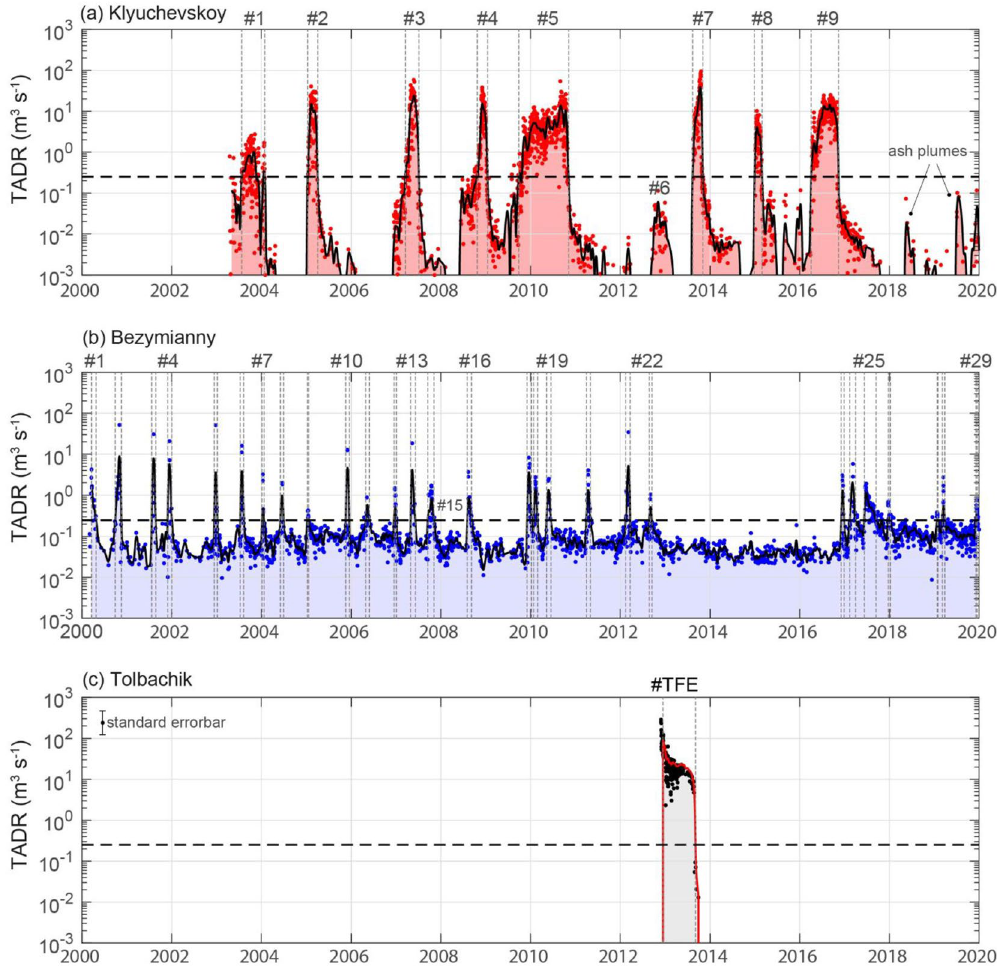
Figure 2. Time-series of the time-averaged lava discharge rate (TADR; logarithmic scale) for ( a ) Klyuchevskoy, ( b ) Bezymianny, and ( c ) Tolbachik. Single satellite measurements (dots) are interpolated and smoothed (line) to provide continuous data. The horizontal dashed lines represent the threshold of 0.25 m 3 s −1 used for automatized detection of eruptions (see “Methods” section). The start and end of each eruptive period (labelled on the top of each plot) are marked by the vertical dashed lines. The error for every single datapoint is ± 50%. The time series is generated using MATLAB software (www. mathw orks. com).